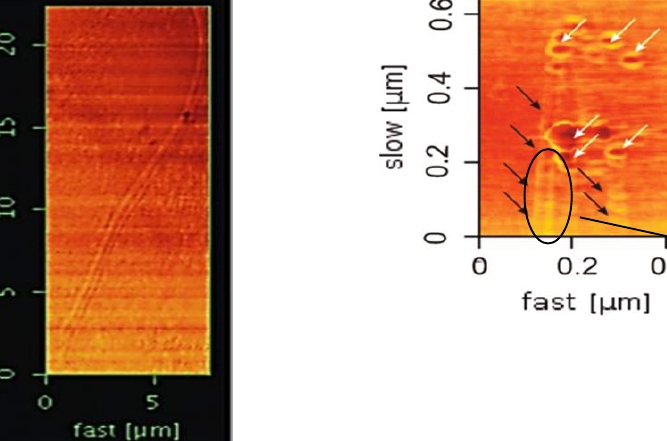
alignments of MNP in the surface of DNTs. The alignment of